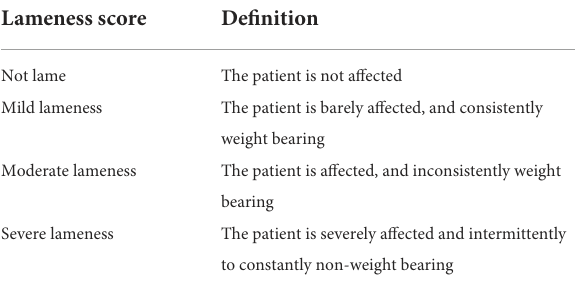
TABLE 1 Four points visual analog scale described by